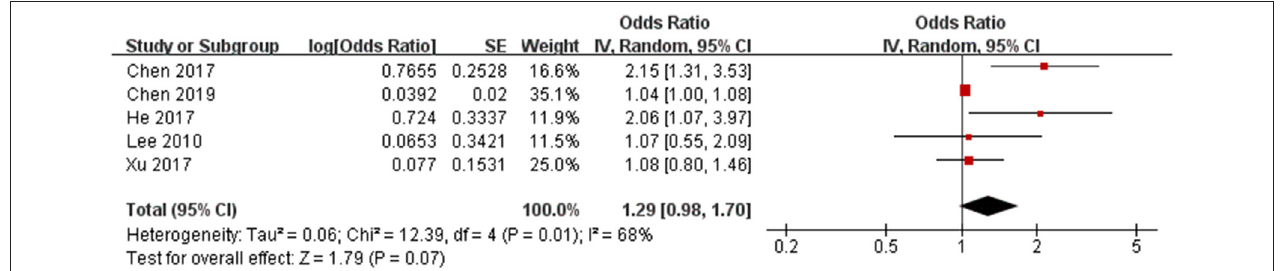
FIGURE 3 | Forest plot of childhood overweight/obesity and the risk of early puberty in boys.